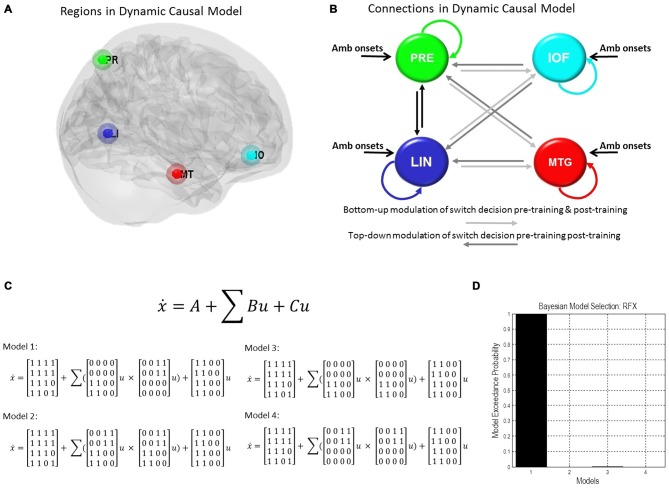
Dynamic causal model and Bayesian model selection. (A) Sources for the Dynamic Causal Modelings (DCMs) were obtained from the second level analysis, displayed here. Regions of interest were identified around the group peak coordinates for Lingual [−6 −68 −2], Precuneus [−12 −70 36], Mid Temporal [50 30 −6], and Inf Orbitofrontal [62 −22 −6]. (B) The four regions of interest (ROIs) were used to create a stochastic DCM. There were intrinsic connections within all regions and between all regions, except for the inferior orbitofrontal cortex (IOF) and middle temporal gyrus (MTG). (B) Inputs from ambiguous image onsets entered all regions. The modulations in connections associated with pre-switch events were tested using Bayesian model comparison. In model 1 pre-switch connections in the pre-training block were confined to bottom-up connections (light gray), i.e., from Lingual and PRE to Inferior Orbitofrontal and Mid Temporal Lobe. While in model 1 post-training switches were modeled via top-down connection modulations only (dark gray), i.e., from Inferior Orbitofrontal and Mid Temporal Lobe to Lingual and PRE. Model 2 comprised pre-switch, pre- and post-training modulations in both directions. Model 3 consisted of bottom-up pre-switch modulations for both pre- and post-training modulations. Finally, model 4 involved of top-down pre-switch modulations for both pre- and post-training modulations. (C) We also display the equations used to define each of these models. A is the intrinsic connection parameters matrix. B is the input-dependent or modulatory connection parameter matrix. z denotes the regions. C is the extrinsic influences or input connection parameter matrix. u Represents the inputs. (D) Bayesian model comparison revealed that both younger and older cohorts preferred model 1 (see “Results” Section) and these fixed effects were consistent across most subjects. Here, we illustrate the exceedance probabilities for a comparison including all models from both age groups.